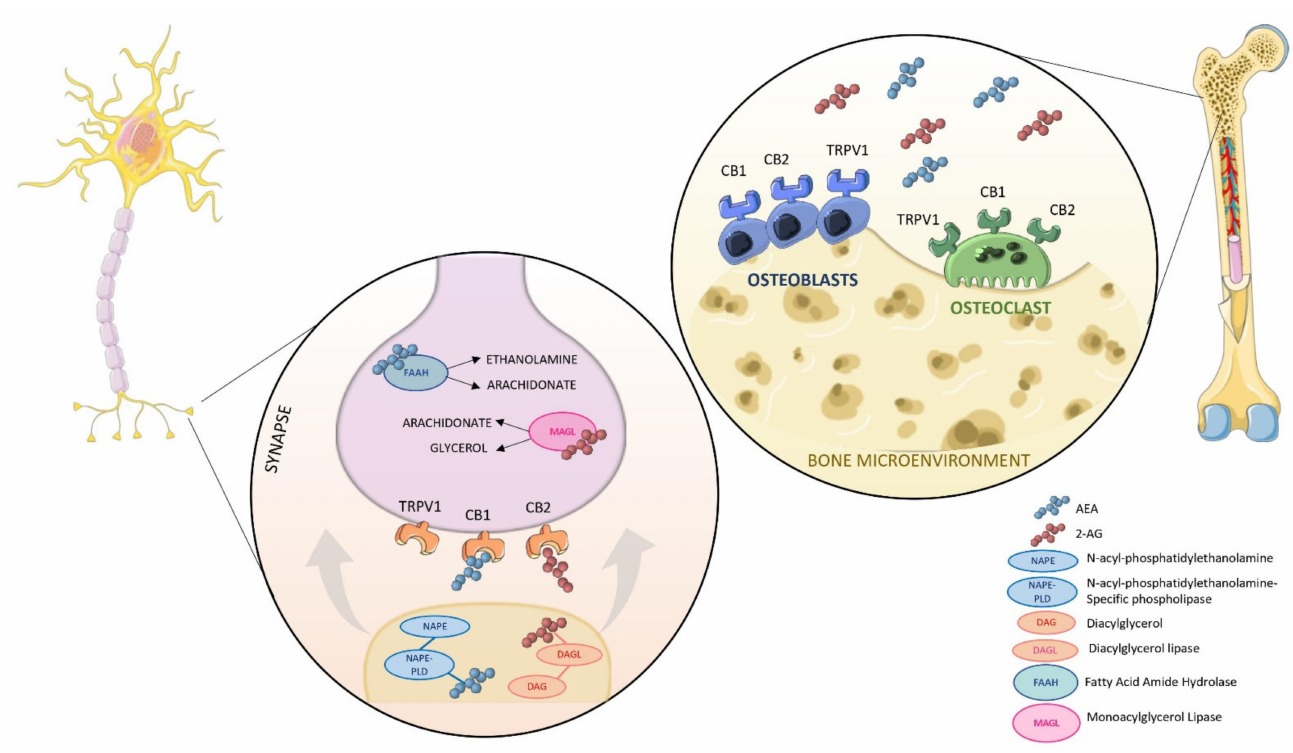
Figure 3. A schematic overview of the skeletal ECS. Right panel shows endocannabinoids anandamide (AEA) and 2- arachidonylglycerol (2-AG), which are found in the bone microenvironment. Endocannabinoid receptors CB1, CB2, and TRPV1 are located on osteoblast and osteoclast cell membranes. Left panel shows the sympathetic innervation of bone. Axons from dorsal root ganglion neurons travel to periosteum and cortical bone. Postganglionic synaptic structures synthesize endocannabinoids on demand and release these lipophilic compounds into the synaptic cleft, where they travel in a retrograde direction to bind to membrane receptors found on osteoblasts and osteoclasts. Osteoblasts and osteoclasts contain enzymes for endocannabinoid synthesis (NAPE, NAPE-PLD, and DAGL) and degradation (FAAH and MAGL). AEA is degraded by FAAH into arachidonate and ethanolamine, whereas 2-AG is metabolized by MAGL into arachidonate and diacylglycerol